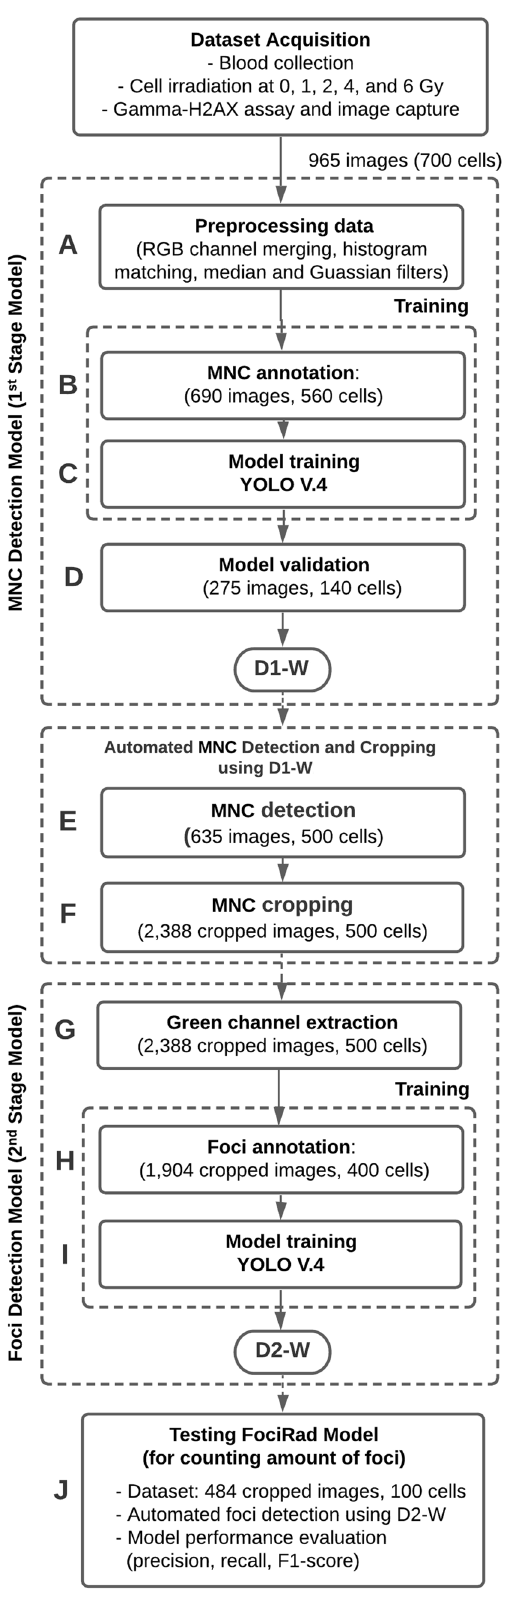
Figure 1. Schematic diagram of the proposed concatenated deep-learning approach (FociRad). Workflow starts from dataset acquisition process. The dataset was imported into the FociRad two-stage detection models, i.e. mononuclear cell (MNC) and foci detection models. D1-weighted for MNC detection (D1-W) was obtained from step A to D. Automated MNC detection and cropping process using D1-W was performed in step E and F. D2-weighted for foci detection (D2-W) was obtained from step G to I. Finally, the performance of FociRad model for counting number of foci using test dataset was evaluated in step